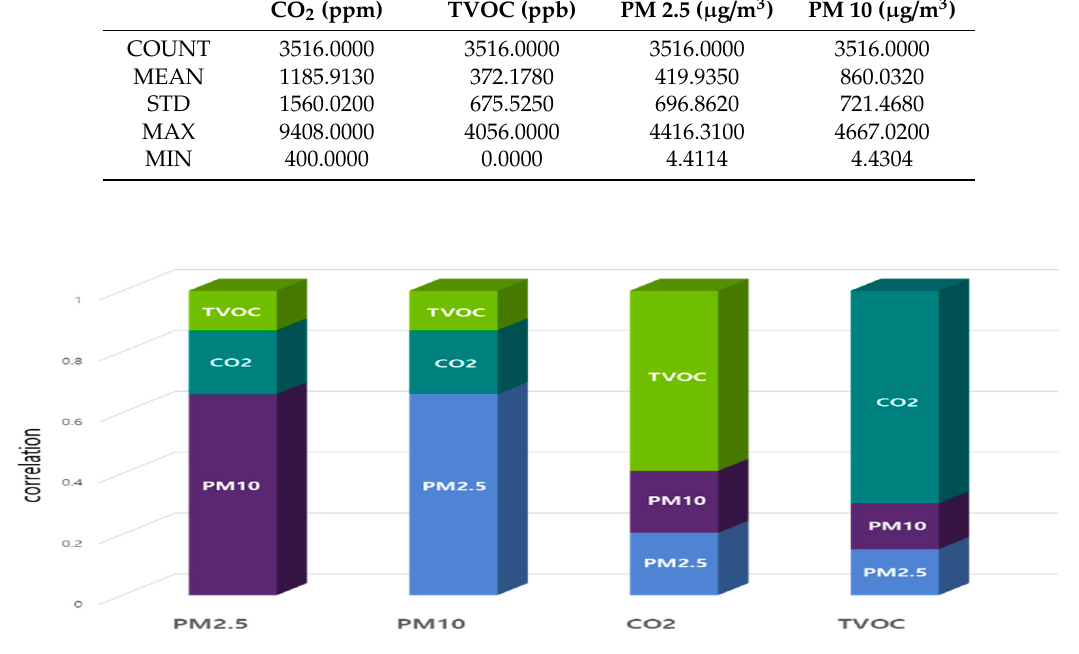
Table 4. Data change depending on the situation.